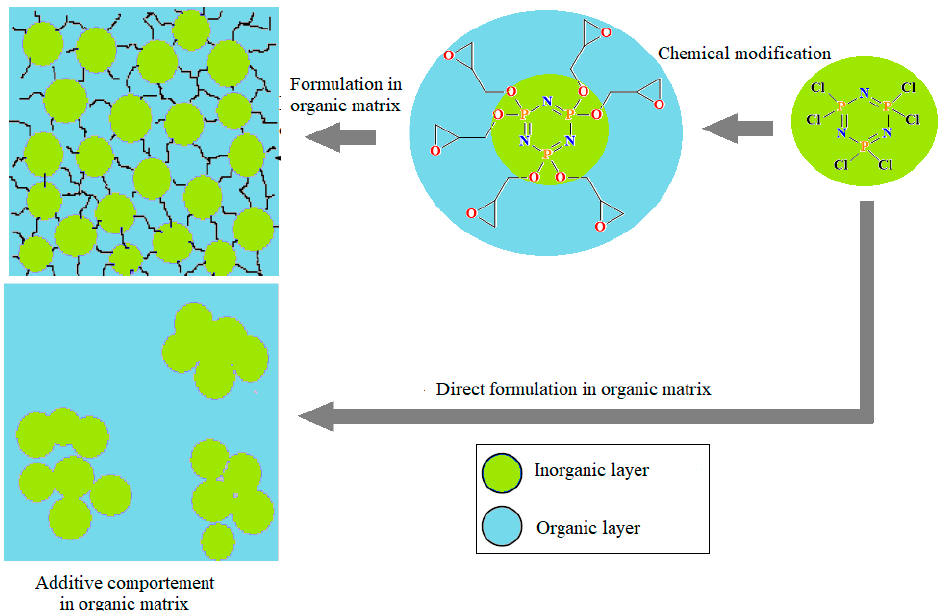
Figure 3. Dispersed hexaglycidyl of cyclotriphosphazene (HGCP) in an organic matrix diglycidyl ether of bisphenol A